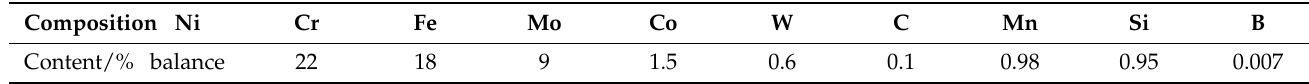
Table 3. The mechanical properties of Rene’80 and Hastelloy X.